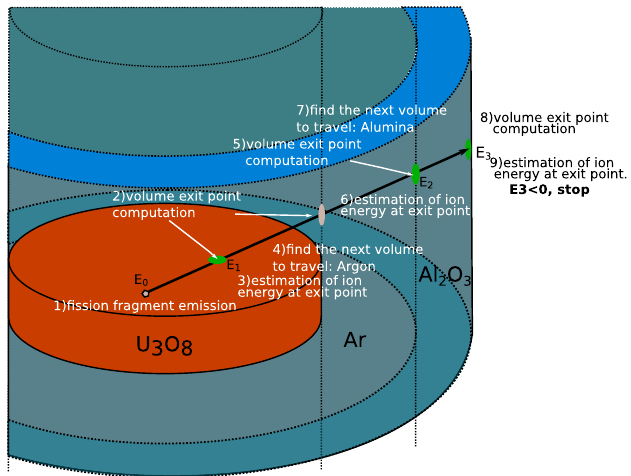
Fig. 8. Example of a fission fragment propagation across a pla- nar geometry. Green ellipses represent the selected exit point while grey ones are those computed but discarded. The red cylin- der correspond to a U 3 O 8 deposit from which fission fragments originated. The light blue cylinder is a volume of argon while the outer dark blue cylinder shell is